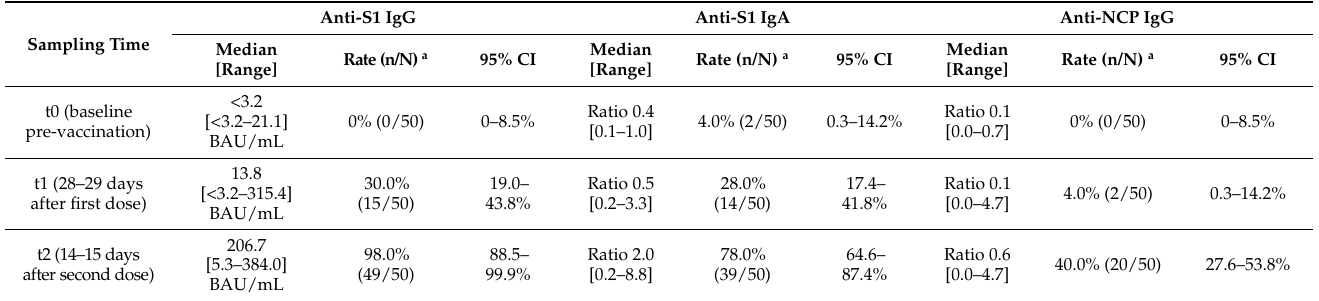
Table 1. Median titers and positivity rates of SARS-CoV-2-specific antibodies in 50 Turkish adults before and after administration of two doses of CoronaVac